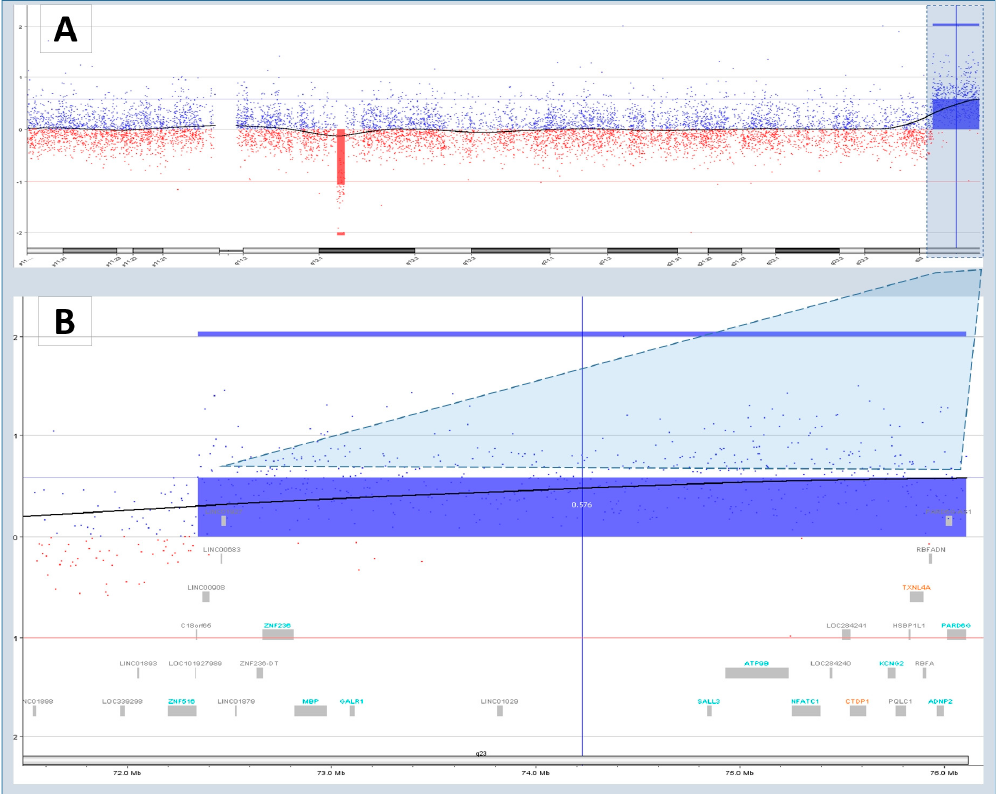
Figure 3. ( A ) Chromosomal microarray analysis showing 3.7 Mb duplication of 18q23 in a 2-year- old patient [BL-464-12] with developmental delay and short stature. ( B ) Detected region (chr18: 72346539_76111023bp) encompasses many pathogenic genes including MBP , CTDP , GALR1 , and